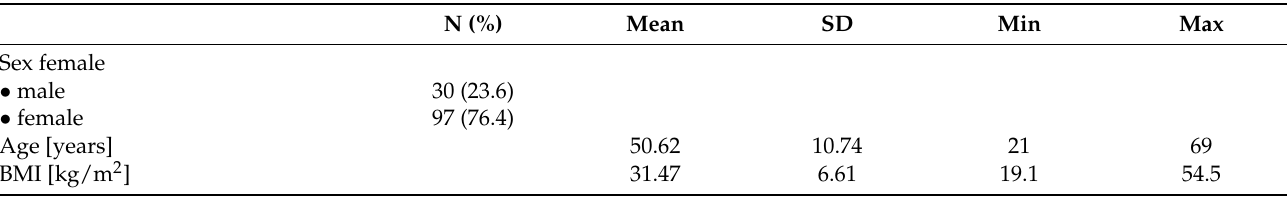
Table 1. Characteristics of the study population (N =